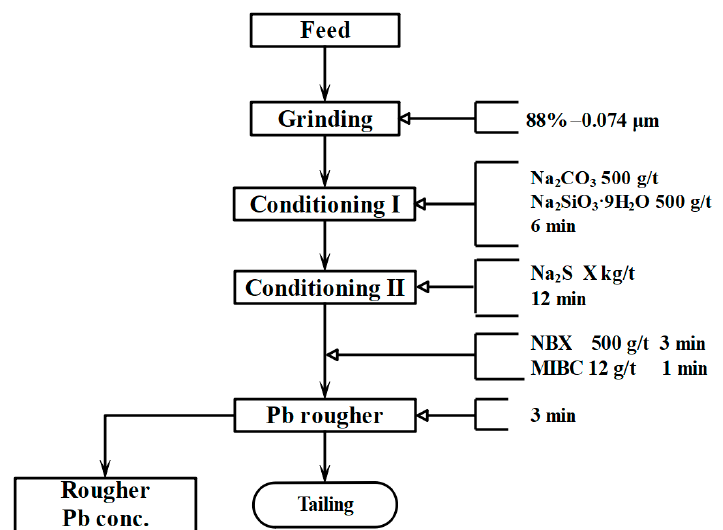
Figure 1. The flowchart of the Na 2 S dosage test.